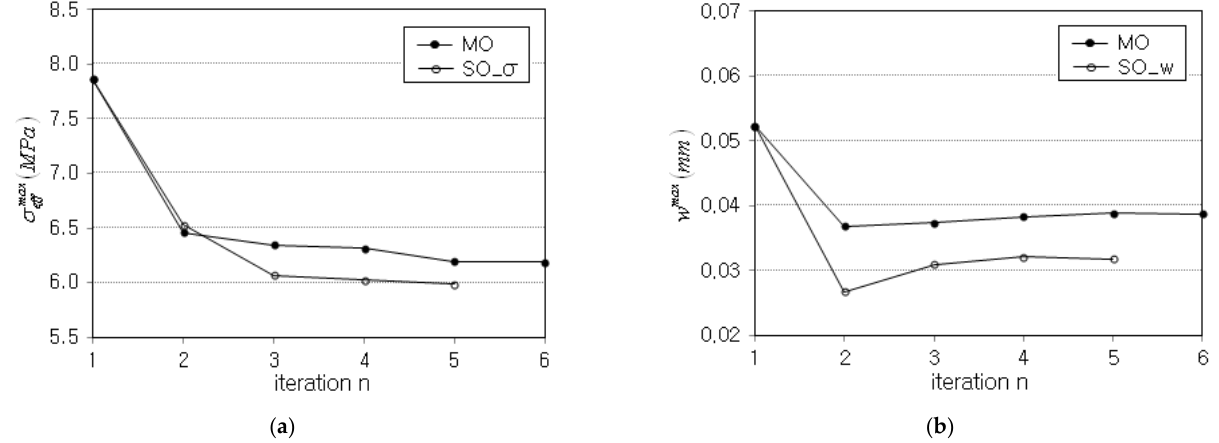
Figure 10. Comparison of iteration histories: ( a ) peak effective stress m a x e ff , ( b ) peak deflection m a x w . Table 7. The optimization results for three different combinations of aspiration